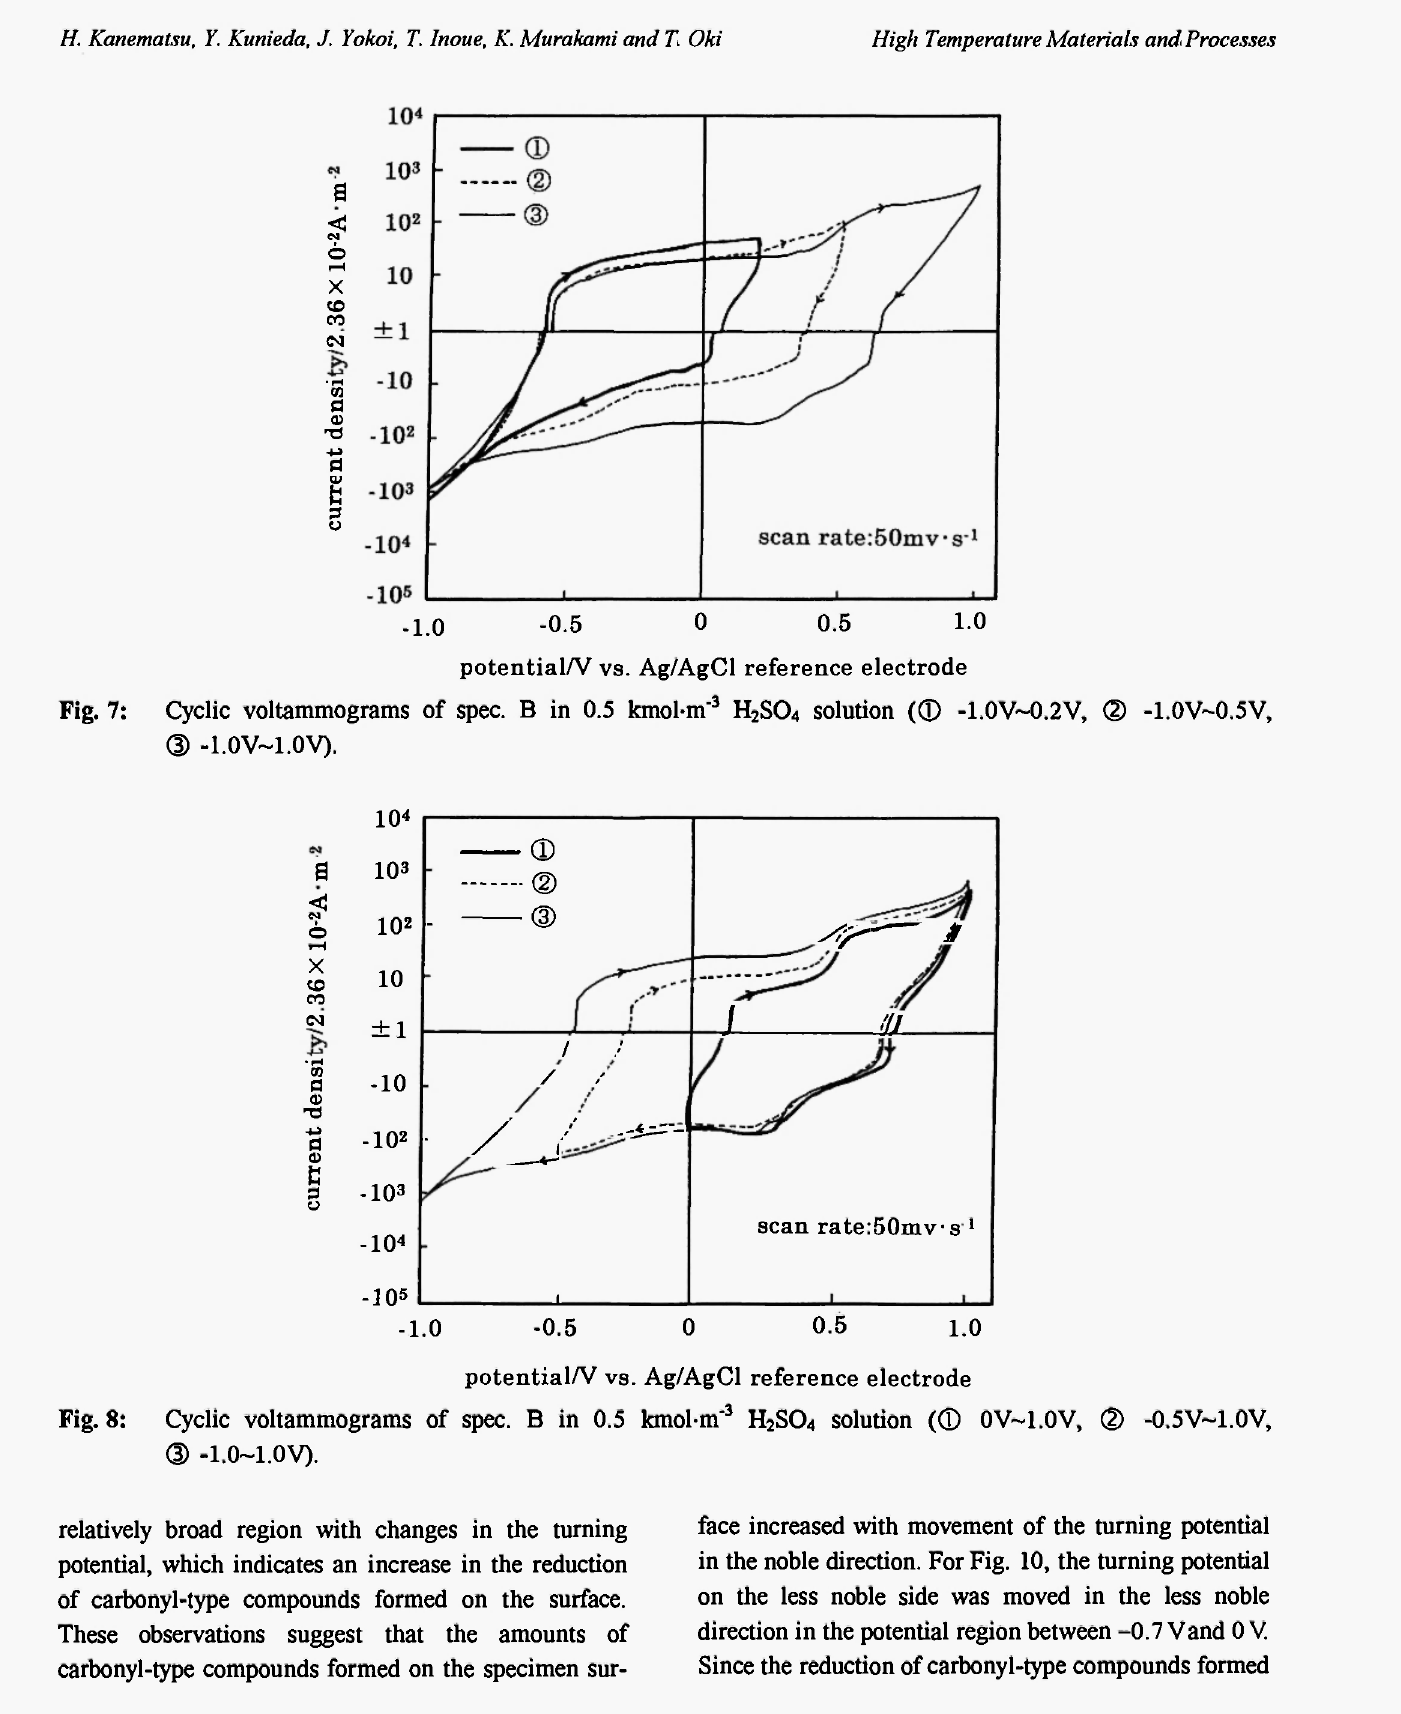
S0 solution (CD 0V-1.0V, © -0.5V~1.0V, 2 4